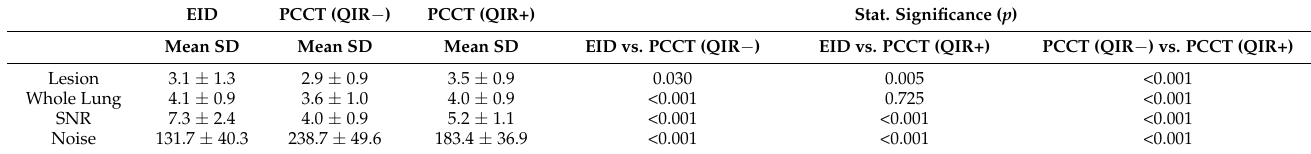
Table 3. Mean values with standard deviation (SD) for image noise on EID, PCCT (QIR − ) and PCCT (QIR+) images of enlarged lesions and the whole lung using a 5-point Likert scale as well as their associated p -values. Additionally, signal-to-noise-ratio (SNR) and noise values are shown. Mean values are based on the rating on the Likert scale assessed by the readers (1—distinct, 2—increased, 3—moderate, 4—little, 5—hardly). Statistical significance was assumed for p -values <